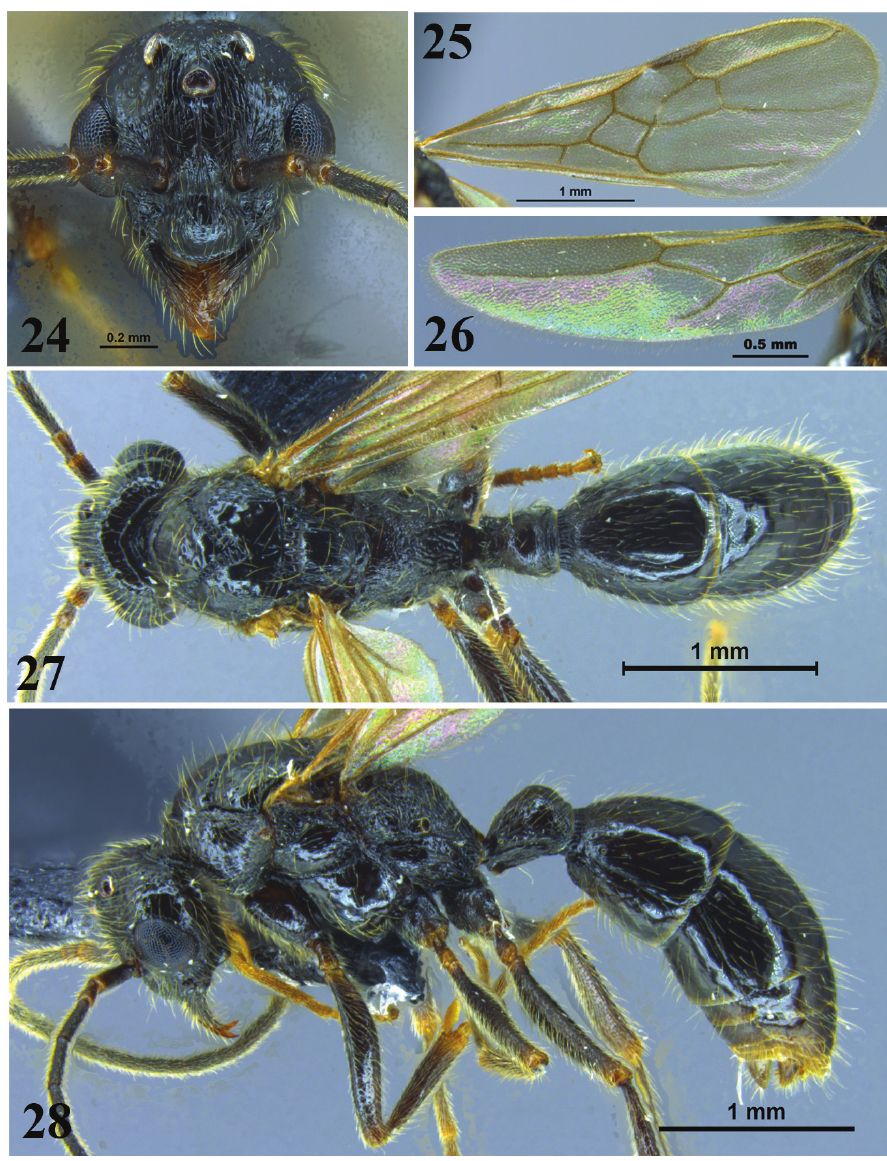
Figures 24−28. Gnamptogenys quadrutinodules paratype male (No. G120081). 24 head in full-face view 25 forewing in dorsal view 26 hindwing in dorsal view 27 body in dorsal view 28 body in lateral view.